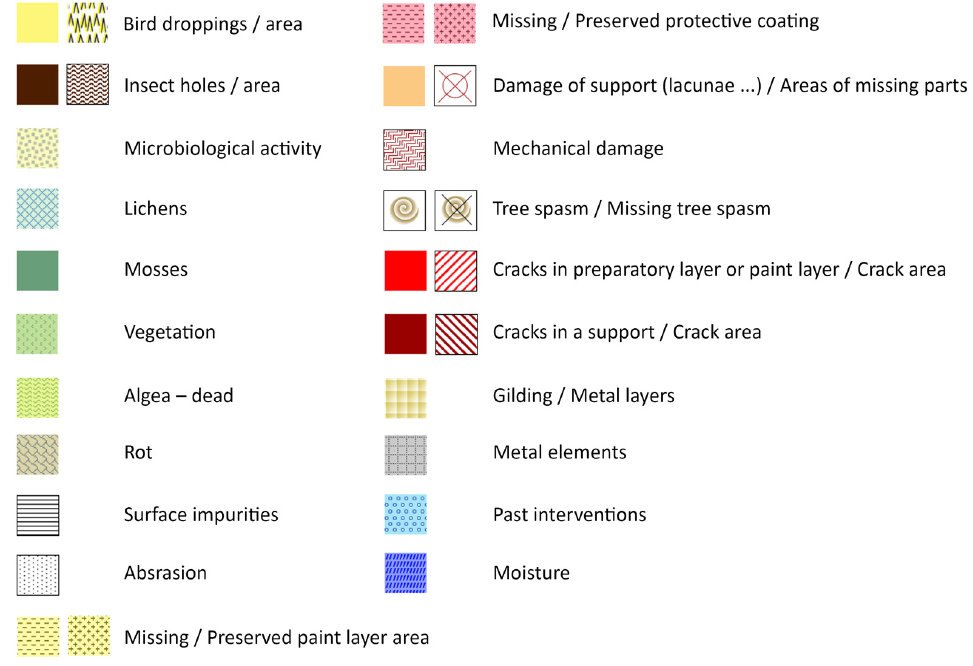
Figure 3. Legend of patterns representing different types of damage and other conditions (authors: